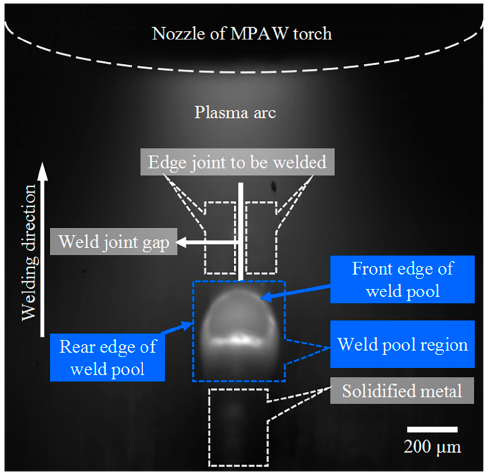
Figure 4. The top view of a typical weld pool in MPAW of edge weld with 0.12 mm-thick sheets.